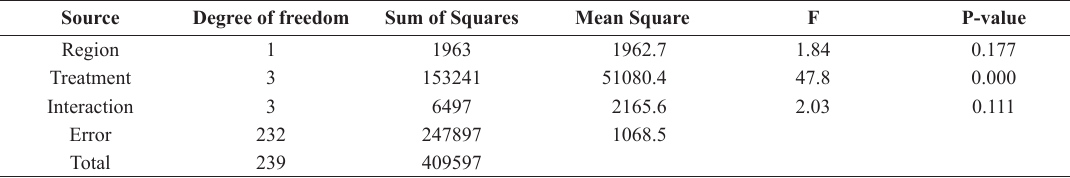
Table 2. ANOVA statistical analysis for mechanical behavior of BFs.